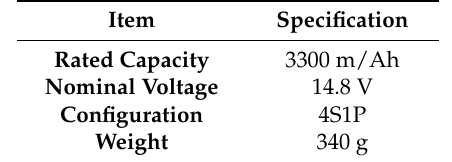
Table 5. Specifications of the battery pack.